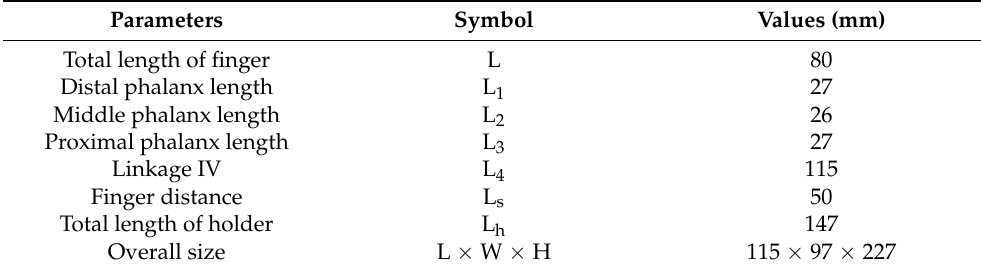
Table 3. Geometric parameters of the underactuated gripper.